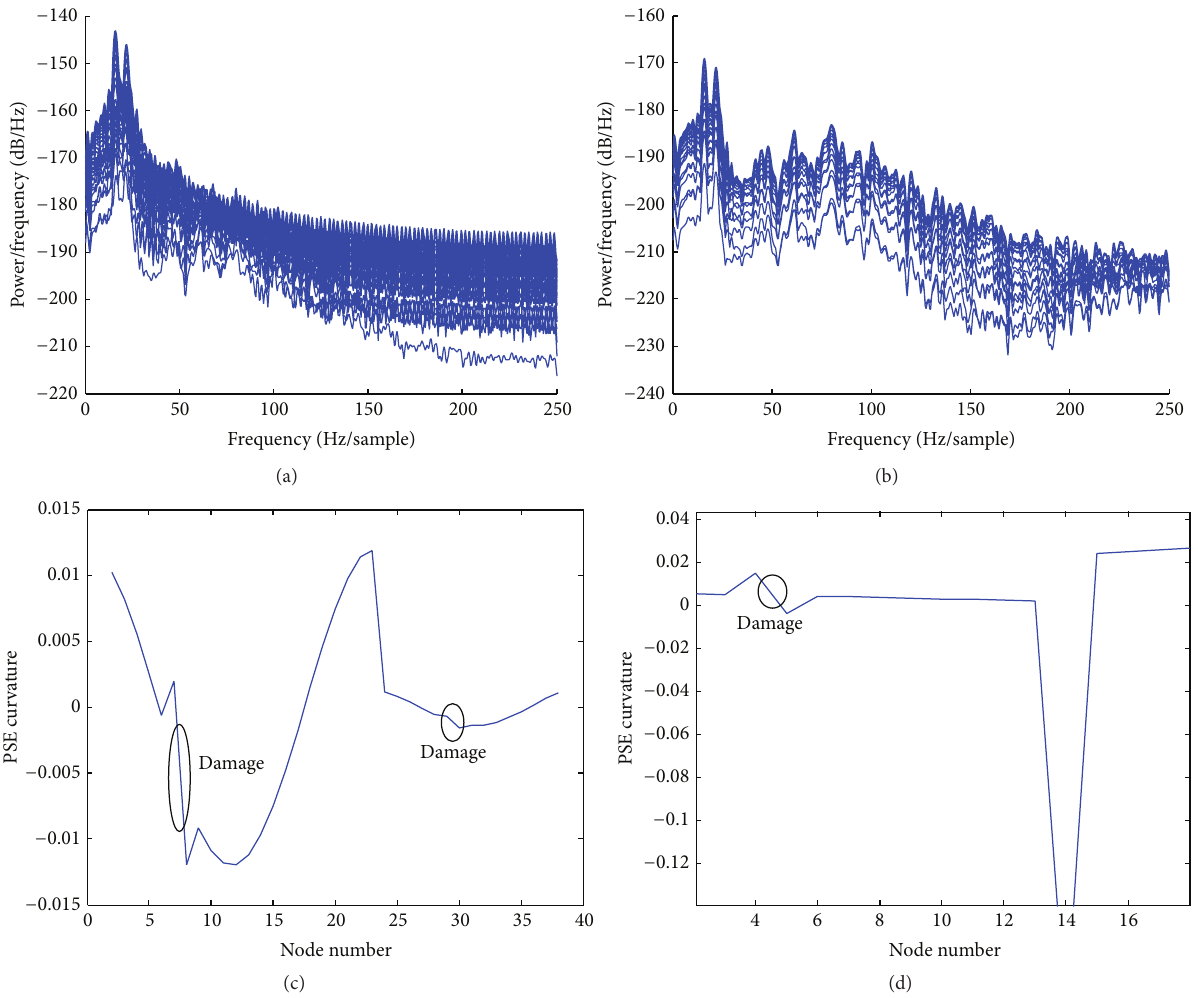
Figure 9: PSE and the curvature curves of noise-free structure: (a) PSE curves of beam 1, (b) PSE curves of beam 2, (c) PSE curvature of beam 1 using the maximum PSEs at the first resonance frequency, and (d) PSE curvature of beam 2 using the maximum PSEs at the first resonance